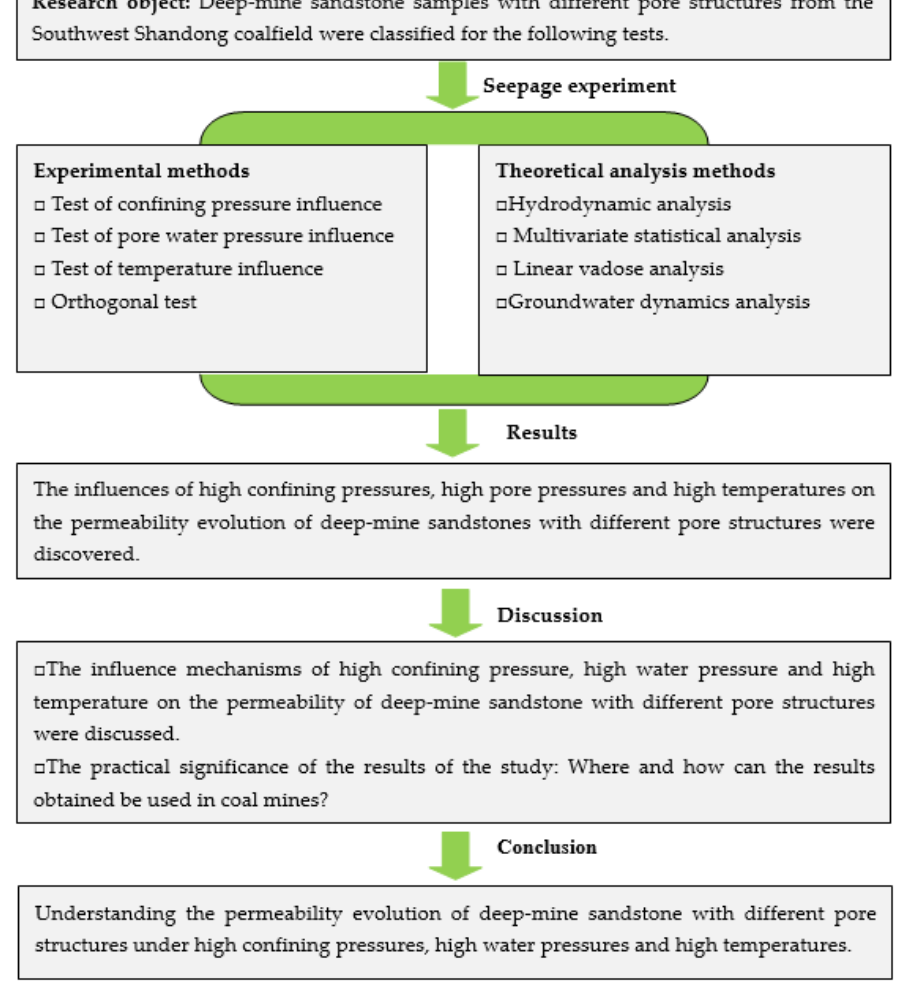
Figure 1. A general overview of the flow of this study.